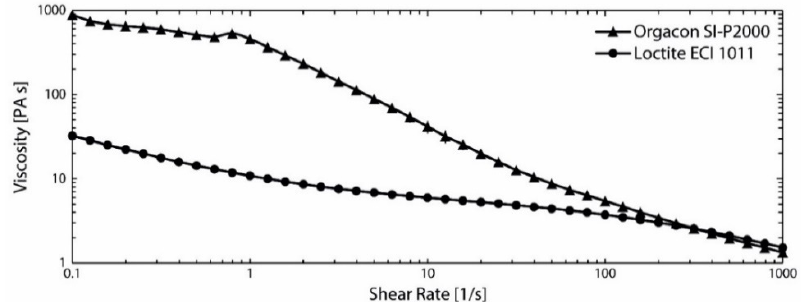
Figure 7. Viscosity as function of Shear Rate of ‘Orgacon SI-P2000 ′ ( ▲ ) and ‘Loctite ECI 1011 ′ ( ● ). Each value is the average of three measurements. The standard deviation is below 5%.